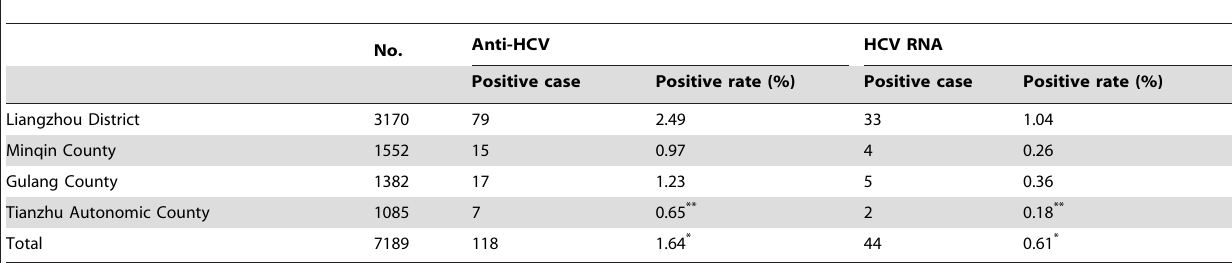
Table 3. Regional distribution of anti-HCV and HCV RNA in